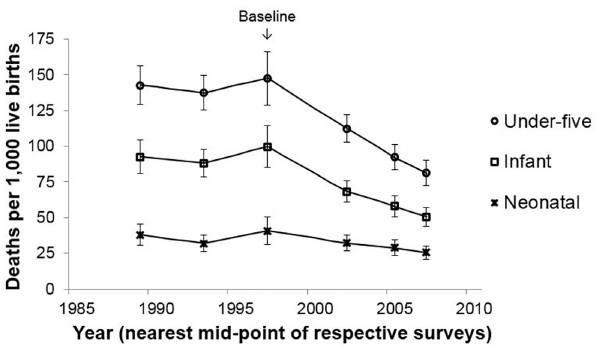
Fig 3. Trends in 5-year estimates of all-cause neonatal, infant, and under-five year mortality rates in Mainland Tanzania, 1990 – 2010. Footnote: Each rate presented as the mid-point of the five-year interval it reflects (e.g., 2010 survey, measuring mortality 2005 – 2009, was plotted at 2007). Mortality among children 1 – 59 months of age declined 54% between 1999 and 2010 (from 111 to 57 deaths per 1000 live births) compared to the 45% relative decline for the traditional 0 – 59 month age group described in